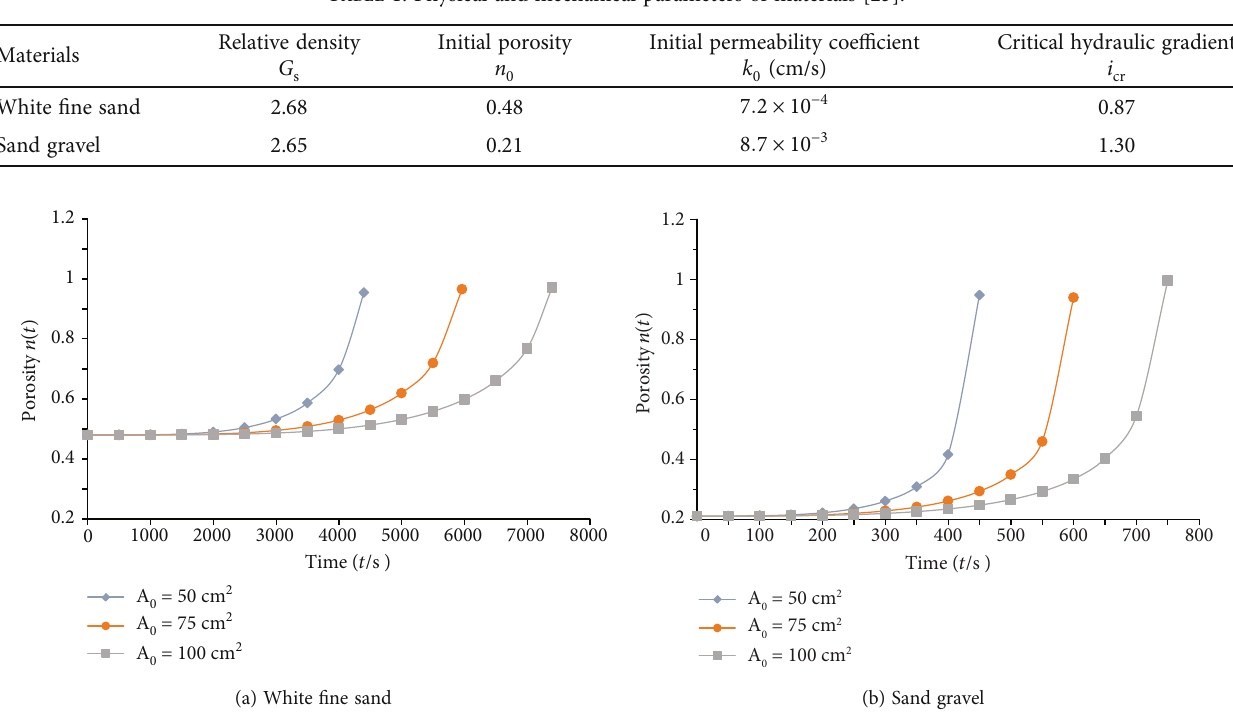
Figure 2: Variation curve between porosity and time at the free surface of soil with di ff erent A